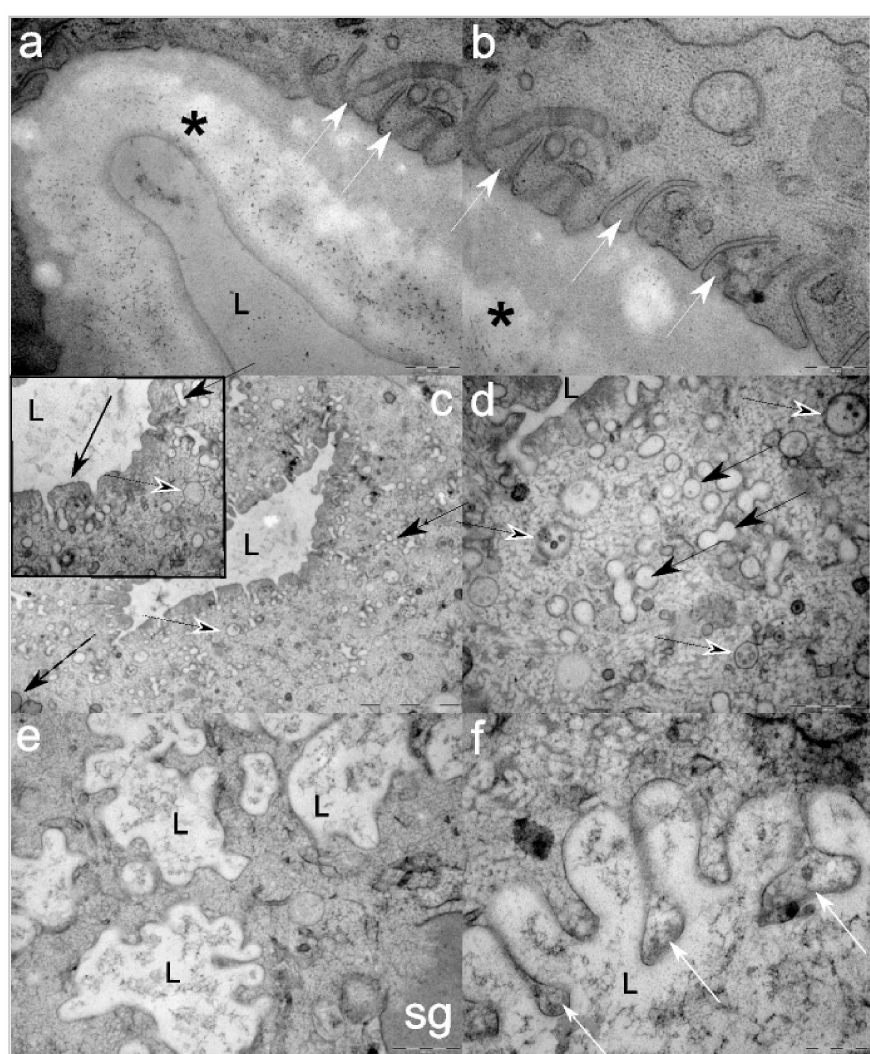
Figure 3. Representative electron micrographs of third-stage Anisakis pegre ffi i excretory cells: ( a ) lumen (L) of the excretory duct lined with a thick proteinaceous layer (*) and plasmalemma criss-crossed by tubular structures of varying diameters (white arrowheads); ( b ) detail of tubular (white arrowheads) structures opening beneath the excretory duct proteinaceous layer (*); ( c ) Lumen of the canaliculus (L) where intensive endocytic processes take part. Note small empty endosomes (solid black arrowhead), endosomes with interior vesicles (black arrowhead), and rare mitochondria (dashed black arrow). Insert: Detail of the lumen of the endocytic canaliculi (L) showing conspicuous electron-dense extravagination of the plasmalemma (black arrow), empty endosomes (solid black arrowhead), and endosomes with interior vesicles (black arrowhead); ( d ) Cytoplasm beneath endocytic canaliculi showing abundant empty endosomes (solid black arrowhead) and endosomes with interior vesicles (black arrowhead); ( e ) Multiple lumens (L) of excretory canaliculi (discharge tubules by Lee et al. [26]) filled with granulo-fibrillar material. Note the discharging of a large electron-dense secretory granule (sg) in the vicinity of the lumen; ( f ) Extravaginations of the excretory canaliculus showing budding of the material (white arrows) to be discharged in the lumen (L). Scale bars: ( a ) and ( b ) 200 nm; ( c ) 2 µ m (insert 500 nm); ( d ) and ( e ) 500 nm; ( f ) 200